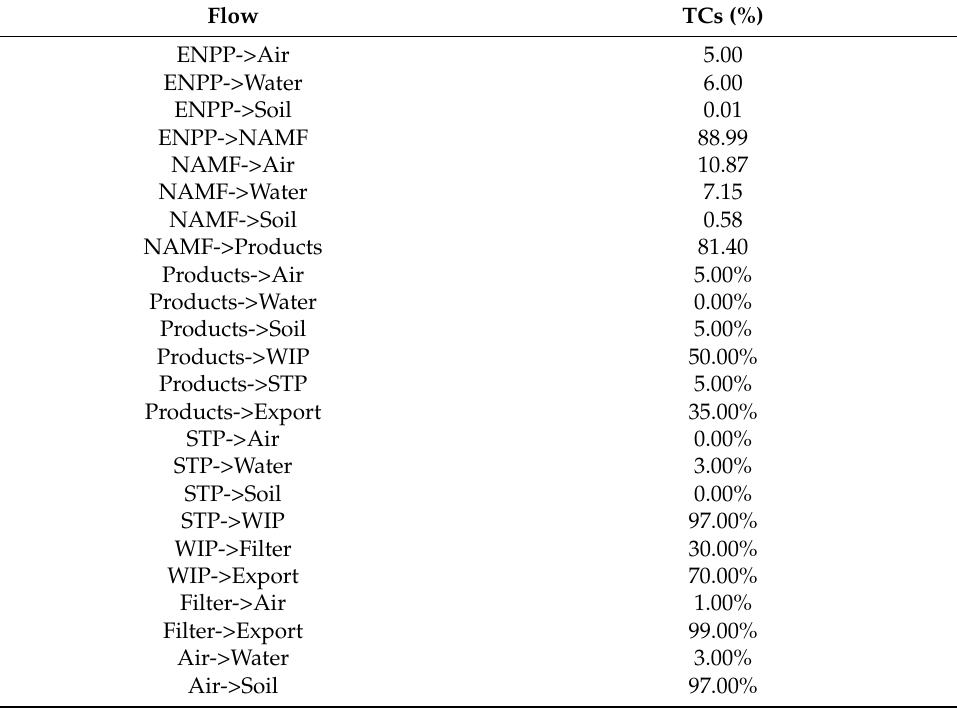
Table 1. Transfer